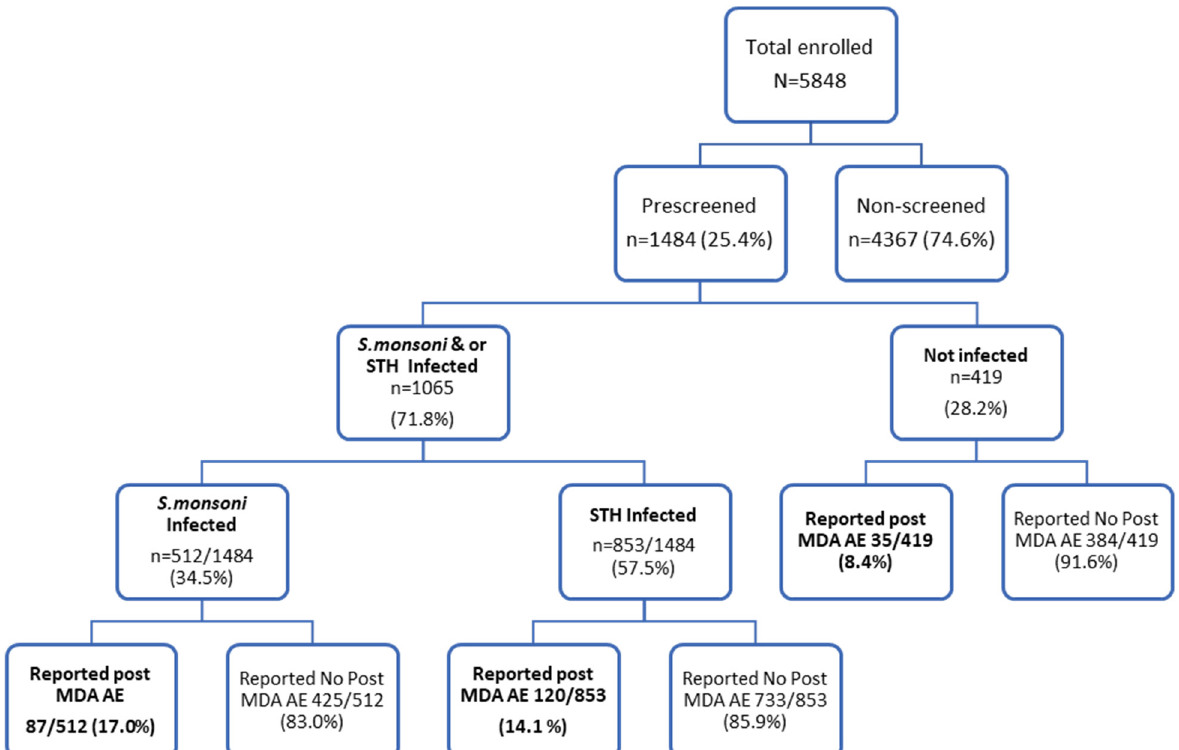
Figure 1. Study flow chart of prescreened participants for S. mansoni and soil-transmitted helminth (STH) infections before receiving mass drug administration (MDA) and safety outcomes after MDA stratified by infection status. AEs = adverse events.